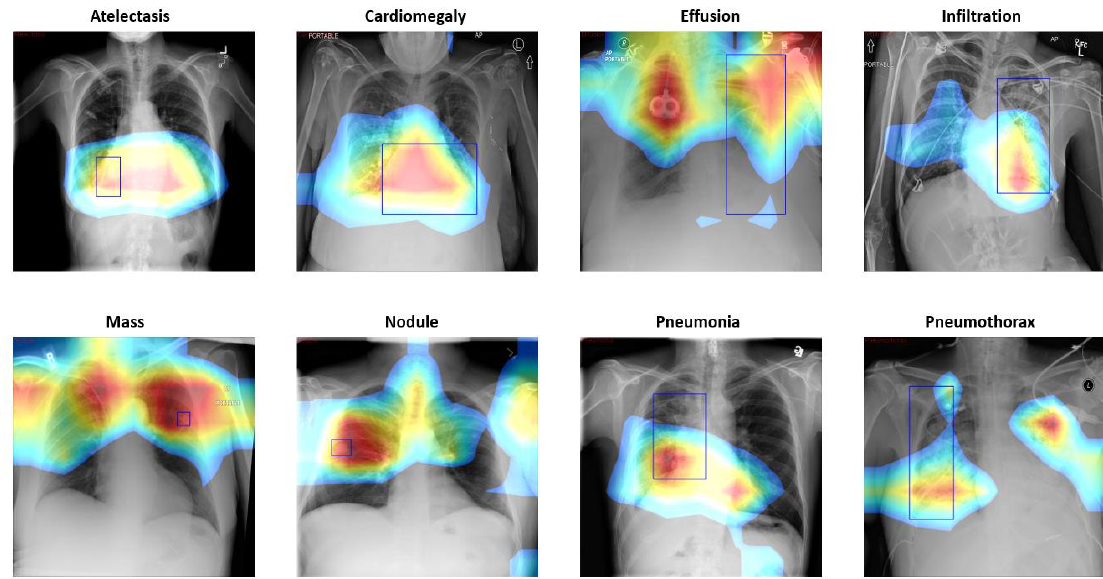
Figure 5. Example CAM results based on Pretrained DenseNet-121, which extracts the weight activations from the last convolutional layers and generate CAMs for 14 pathologies.